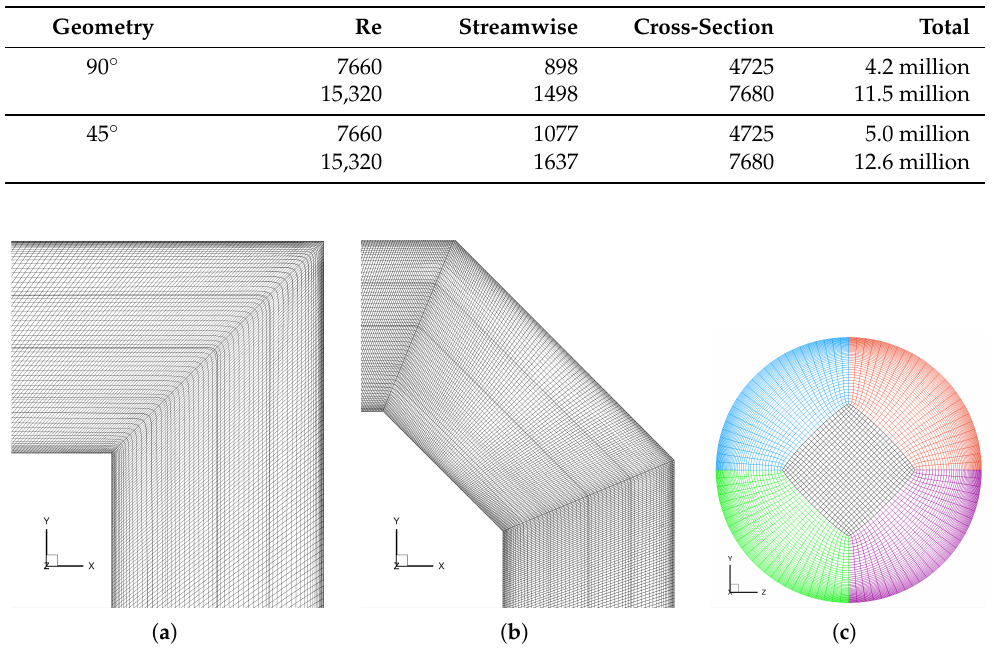
Figure 6. Cross-section views of the computational grids of both bend configurations at Re L . The grids for the high Reynolds number Re H differ only in the number of grid cells. ( a ) x - y cross-section of the grid for the 90 ◦ pipe bend at z / D = 0. Only every second grid line is shown. ( b ) x - y cross-section of the grid for the 45 ◦ pipe bend at z / D = 0. Only every second grid line is shown. ( c ) Computational grid at the inlet for both investigated pipe bend configurations at x / D = 0. All grid lines are